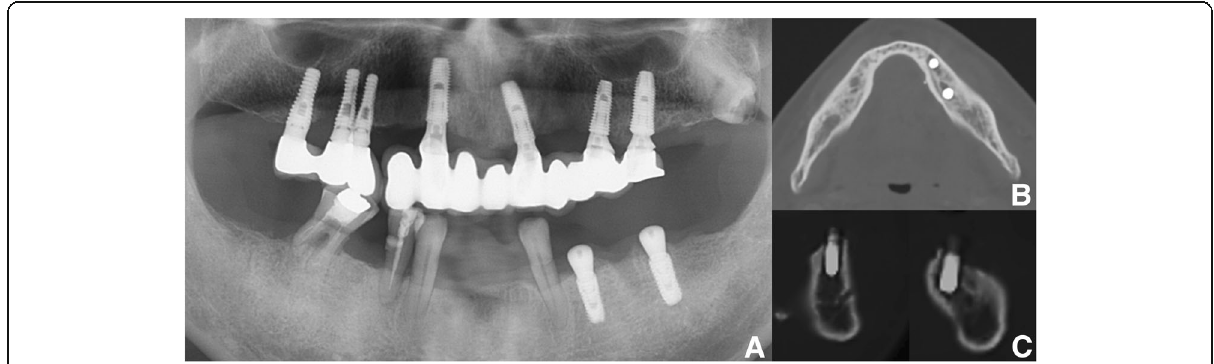
Fig. 4 a Panoramic view: dental implant installation state on mandible Lt. Posterior area (bleeding area). b Axial CT view and c sagittal CT view on implant site showed adequate placement of dental implant without lingual cortex perforation and damage of adjacent anatomic structure. The dental implant installation in the left posterior mandibular